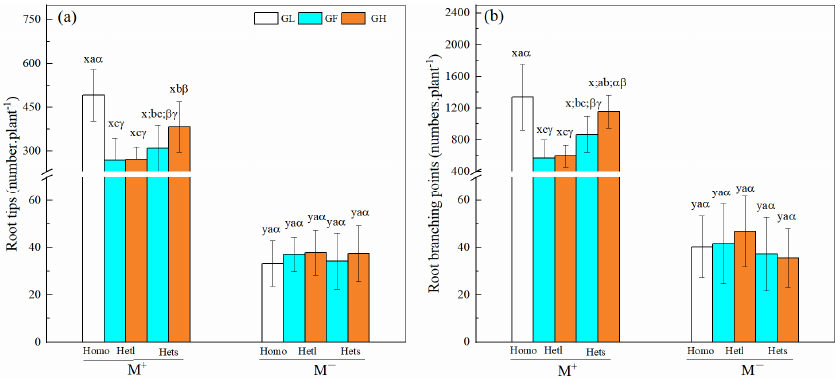
Figure 4. Numbers of root tips and branching points of B. pilosa . ( a , b ) represent the root tips and branching points, respectively. See Figure 2 for an explanation of M + , M − , Homo, Hetl, Hets, GL, GF and GH, lowercase letters (x, y) and (a, b, c) and Greek alphabet ( α , β , γ ).